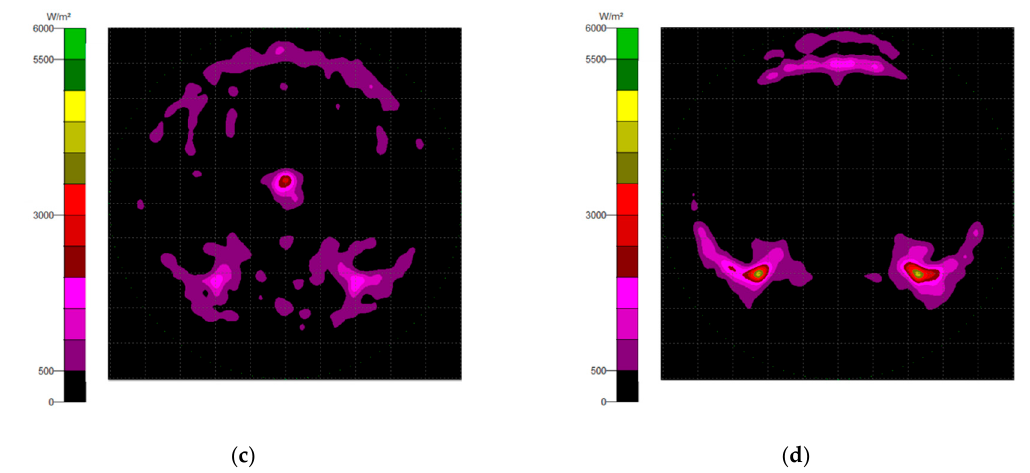
Figure 20. The irradiance distribution of the mirror-NACPC and elliptical collimator with misalignment angles of ( a ) 0 ◦ , ( b ) 10 ◦ , ( c ) 20 ◦ , and ( d ) 30 ◦ . Figure 21. The irradiance distribution of the mirror-NACPC and elliptical collimator with